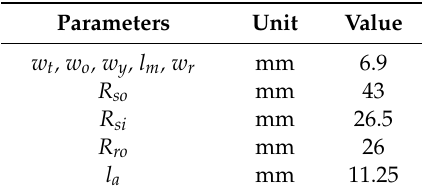
Table 3. The parameters of the as-designed 6 / 5 FSPM.